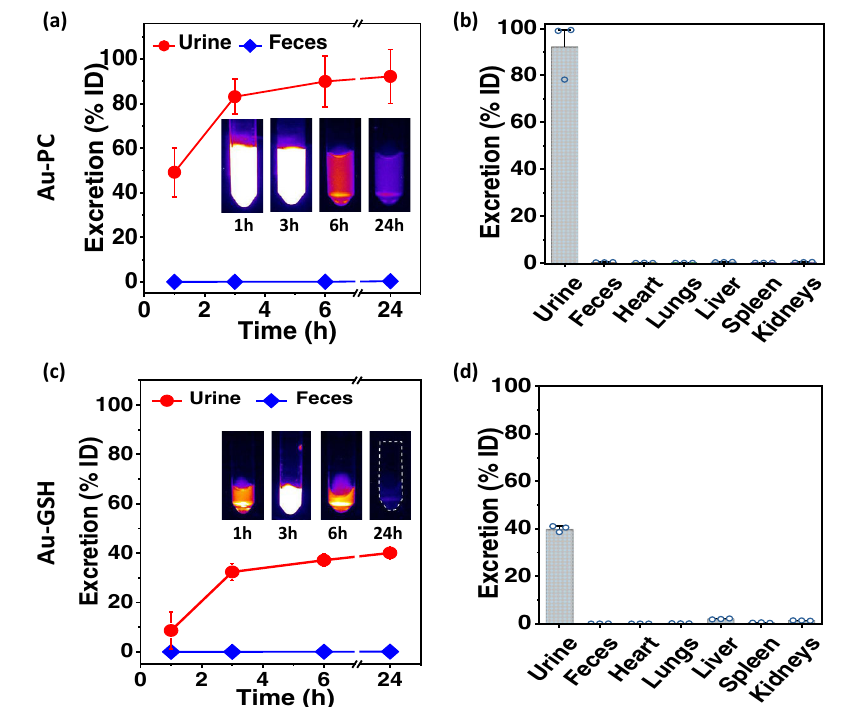
Fig. 4 | Excretion pro fi les and biodistribution after intra-tumoral injection of Au-PC and Au-GSH. a , c Rapid renal excretion pro fi les ( a up to 24h p.i.) and b , d biodistribution in major organs after 48h of intra-tumoral(i.t.) administration of Au-PC and Au-GSH fl uorescent probes into a mouse bearing 4T1 tumors on hindlimbs ( n = 3), respectively. The insets in a and c represent NIR-II fl uorescence